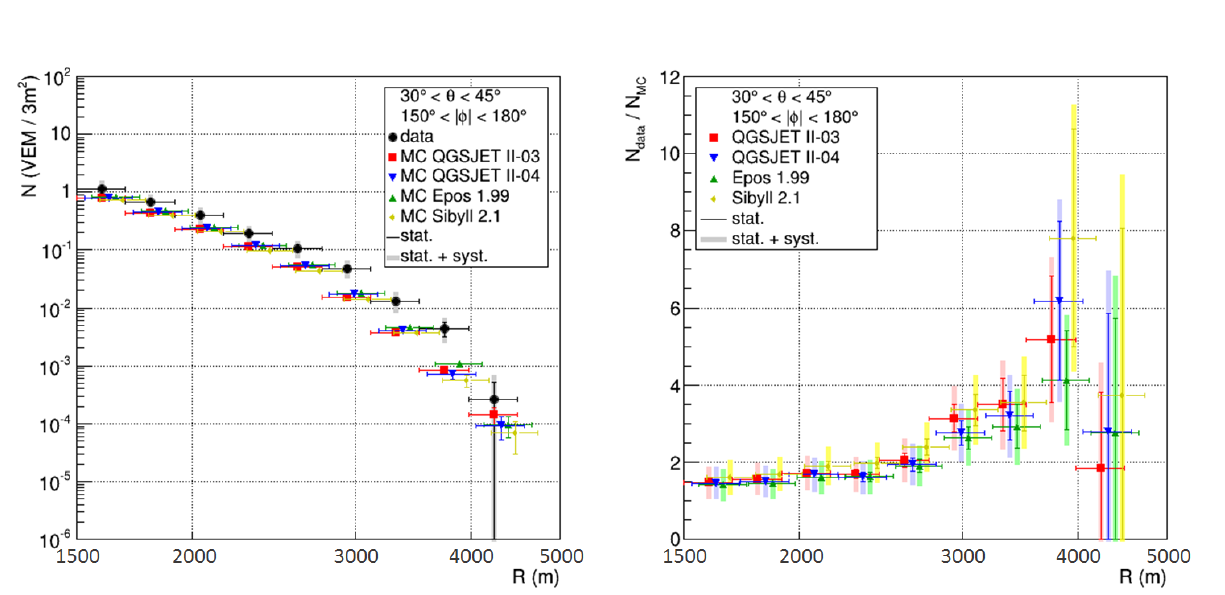
Figure 3. Lateral distributions of air showers for 30 ◦ < (cid:18) < 45 ◦ ; 150 ◦ < j ϕ j < 180 ◦ , 500 m < R < 4500 m [28]. (left) The signal size of data with the MCs using various hadronic models. To make error bars easy to see, the plots for the latter three models are shifted to the right. (right) The average ratio of the data to the MC.